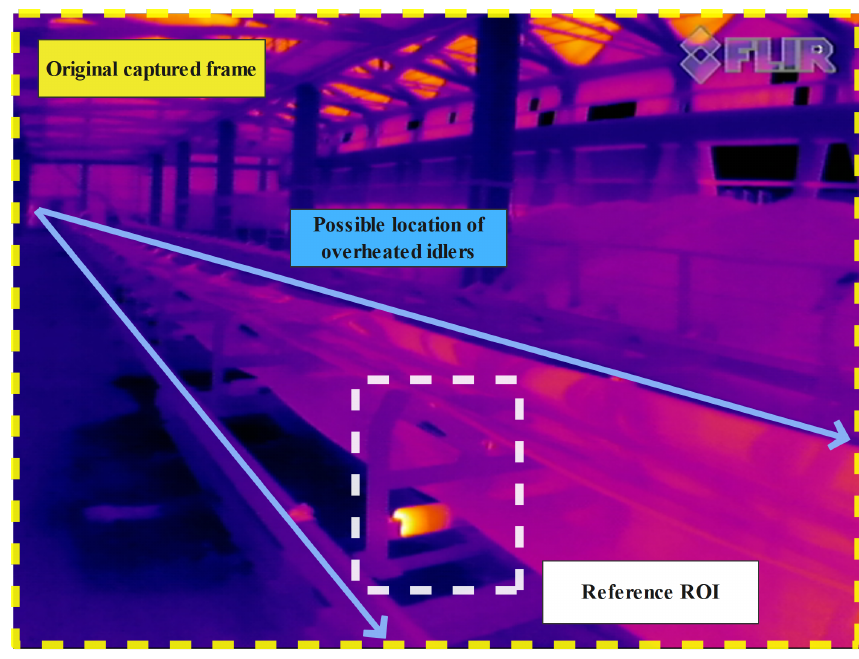
Figure 3. Selection of ROI on the captured IR